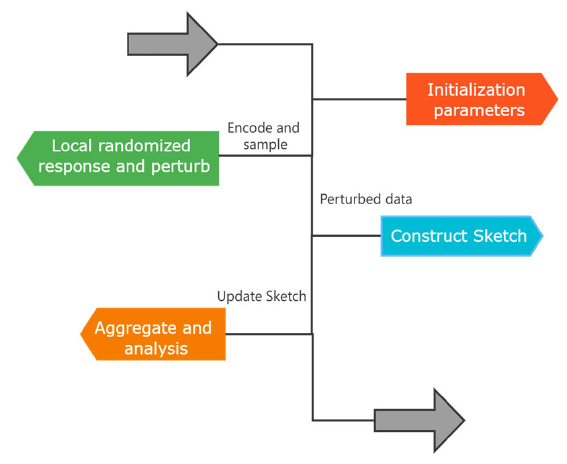
Figure 3. Workflow diagram of the MDLDP algorithm.